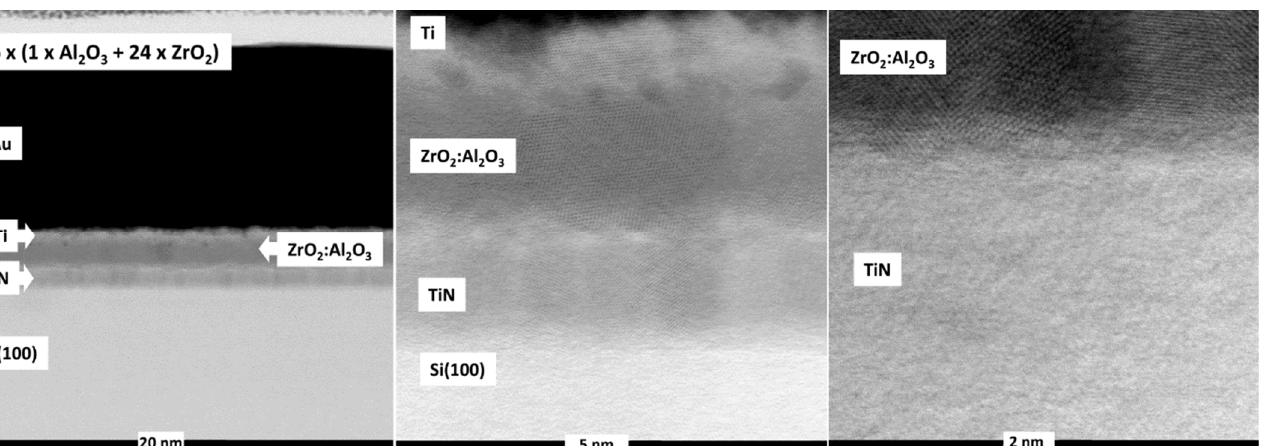
Figure 5. Elemental composition mapping of an Au/Ti/ZrO 2 :Al 2 O 3 /TiN stack containing ZrO 2 :Al 2 O 3 film deposited using the ALD cycle sequence of 6 × (1 × Al 2 O 3 + 24 × ZrO 2 ). The chemical elements (Au [orange], Ti [green], Zr [blue], Al [red] and O [magenta]) as detected and mapped are indicated by the corresponding labels. Note that the high intensity of the Al signal in the Au contact region is due to the X-ray continuum. The intensity of the X-ray continuum is higher in regions with high atomic numbers. Although the X-ray continuum contributes to all maps, the effect is especially pro- nounced in the Al map due to low concentration of Al and, as a result, low signal/background ratio. Figure 6 represents X-ray diffraction patterns of the double-layer Zr x Al y O z -ZrO 2 structures. Quite expectedly, these films showed higher crystallinity in comparison to those deposited as multilayer ZrO 2 :Al 2 O 3 structures. The 10–15 nm thick ZrO 2 layers ob- tained in the Zr x Al y O z -ZrO 2 structures after applying 80 ALD cycles were ordered in the